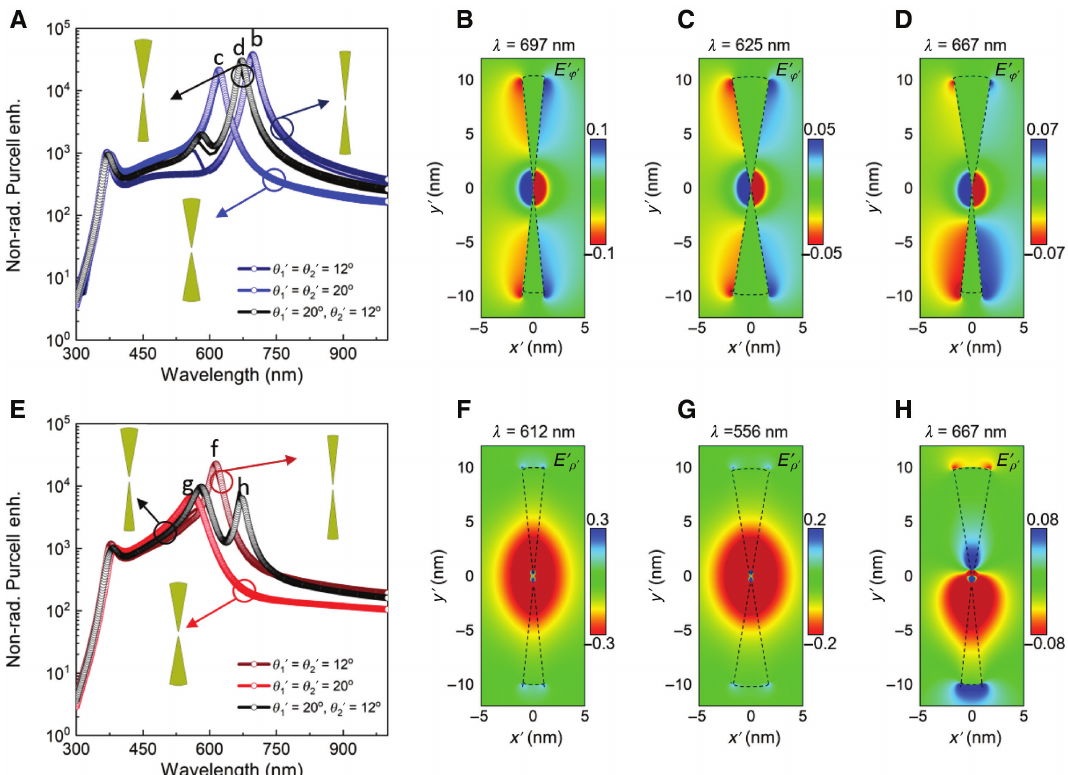
Figure 4: Comparison between symmetric and asymmetric bowtie nanoantennas. The Γ values for different sets of θ ′ and θ ′ corresponding to a vertical (A) and horizontal nanoemitter (E); the solid lines are the 1 2 nr corresponding results obtained with COMSOL Multiphysics. Snapshot of the in (A) and (E), respectively, computed using COMSOL